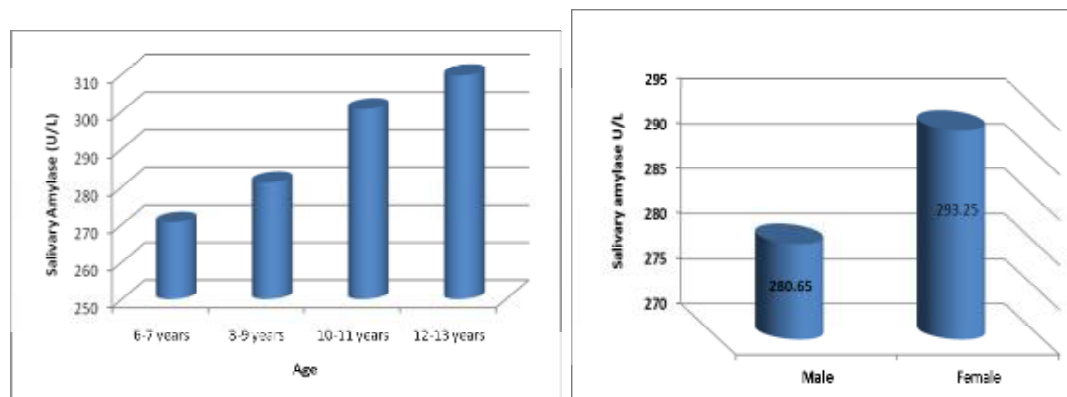
Figure 2: Gender and mean salivary amylase